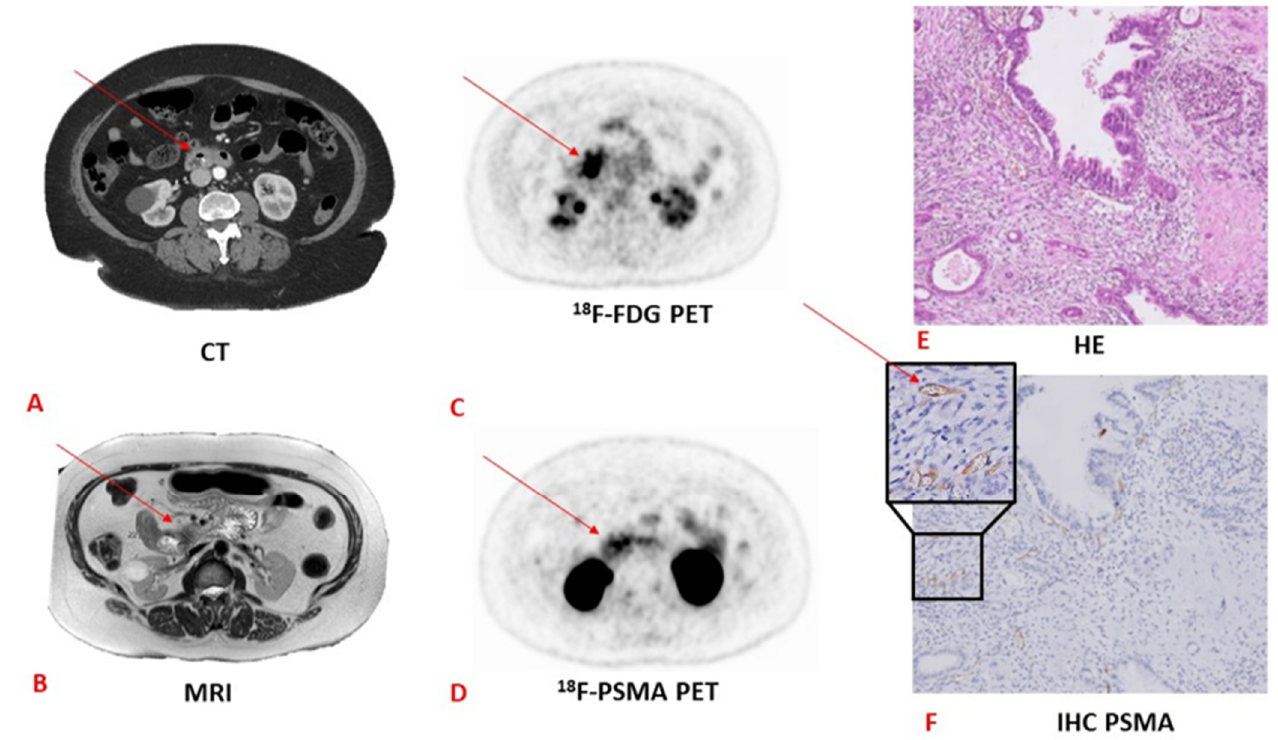
Figure 2. CT versus MRI versus 18 F-FDG versus 18 F-PSMA PET and the corresponding pathology and HE and immunohistochemistry tests in a patient with pancreatic adenocarcinoma. ( A ) CT image with an arrow pointing towards a pancreatic lesion. ( B ) MRI image with an arrow pointing towards a pancreatic lesion. ( C ) 18 F-FDG PET image with an arrow pointing towards a pancreatic lesion. ( D ) 18 F-PSMA PET image with an arrow pointing towards a pancreatic lesion. Note the more specific PSMA uptake compared to the 18 F-FDG PET scan. ( E ) Haematoxylin and eosin staining (HE) image. Adenocarcinoma is not visible on this staining. ( F ) Immunohistochemistry staining of PSMA. The arrow points towards stained PSMA. CT, computed tomography; MRI, magnetic resonance imaging; PET, positron emitting tomography; HE,